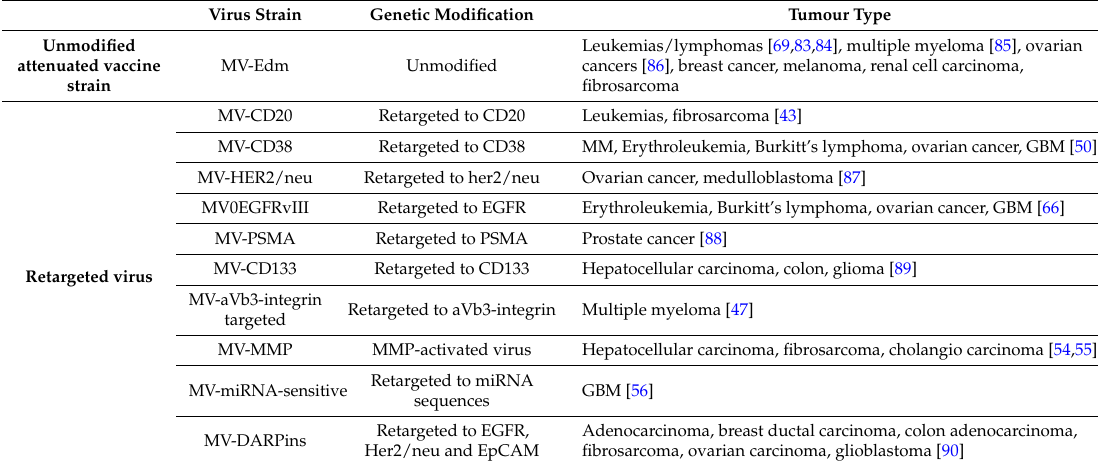
Table 1. Summary of genetically engineered